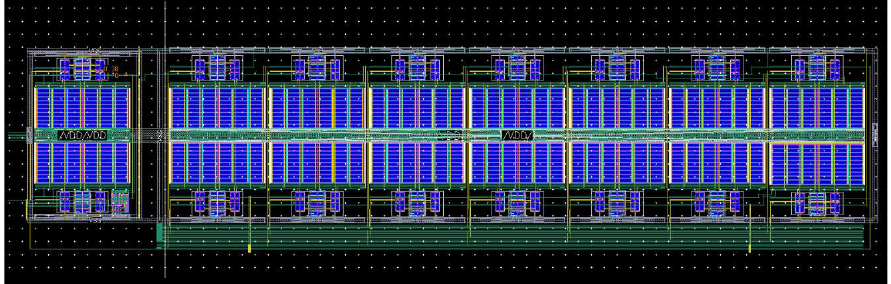
Figure 10. Layout of the implemented fractional-order skin and electrode models (versatile